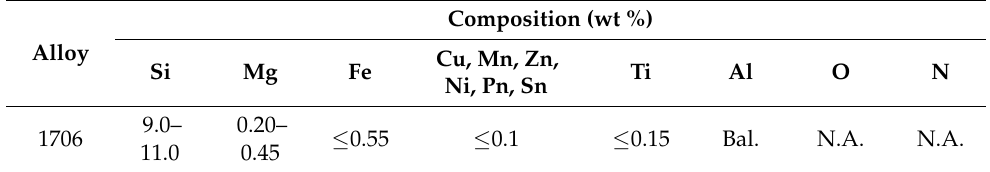
Figure 1. The disk-shaped configuration: ( a ) front view computer-aided design (CAD) model; ( b ) top view CAD model; ( c ) isometric view CAD model, showing the Z-direction (blue arrow); and ( d ) typical additive manufacturing laser powder-bed fusion (AM-LPBF) 3D-printed AlSi10Mg specimen. Table 1. The chemical composition of the AlSi10Mg powder: Basic standard: BS EN 1706:2020.